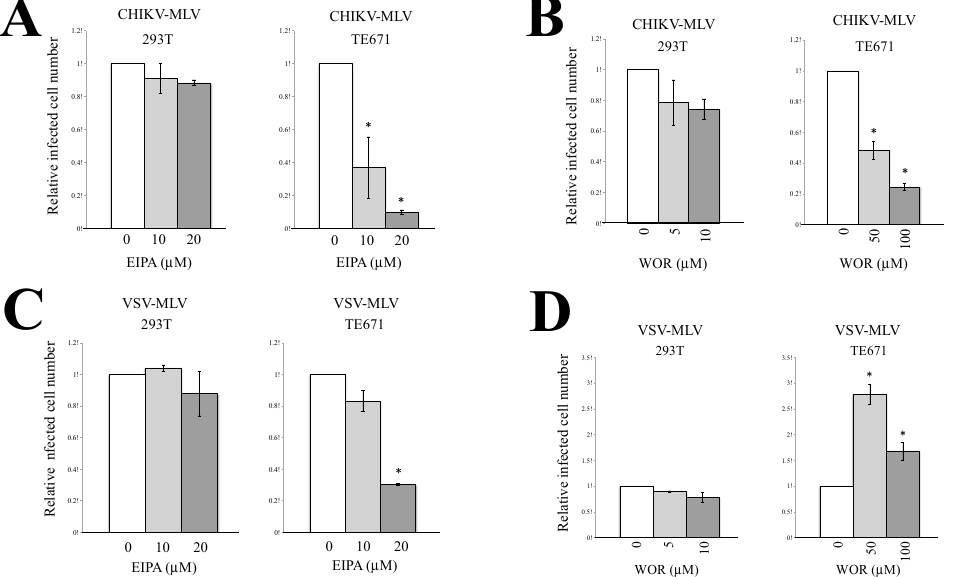
Figure 4. Macropinocytosis is required for CHIKV-pseudotyped MLV vector infection in TE671 cells. 293T or TE671 cells pretreated with the macropinocytosis inhibitor, EIPA ( A , C ), or WOR ( B , D ) were incybated with CHIKV ( A , B )- or VSV ( C , D )-pseudotyped MLV vector. The cells were stained with X-Gal. Relative values to the blue cell numbers detected in the cells treated with the same volume of DMSO are indicated. Blue cell numbers in DMSO-treated cells were always set to 1. This experiment was conducted in triplicate, and averages are shown. Error bars indicate standard deviations. Asterisks indicate statistically significant differences compared to the values in DMSO-treated cells.